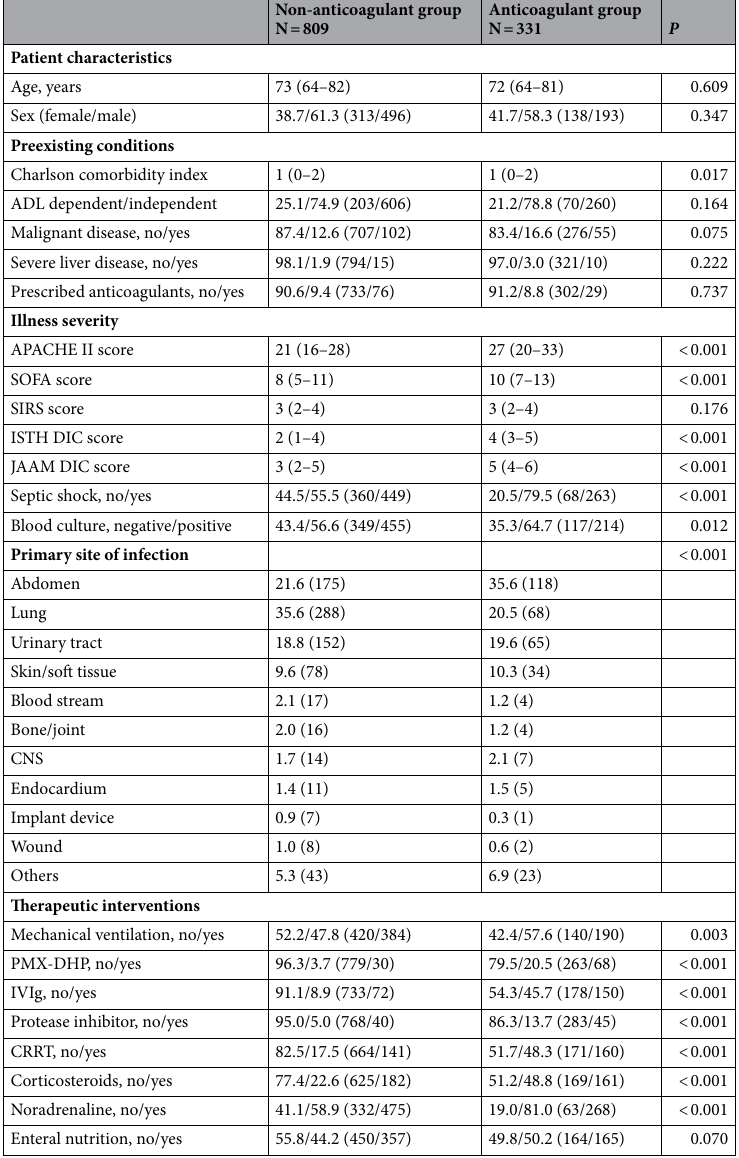
Table 1. Baseline clinical characteristics of the patients who did or did not receive anticoagulant therapy. Data are presented as proportions (counts) for categorical variables and medians (interquartile ranges) for continuous variables. Anticoagulant therapy was defined as the administration of antithrombin, recombinant human thrombomodulin, or their combination in the present study. ADL, activities of daily living; APACHE, Acute Physiology and Chronic Health Evaluation; CNS, central nervous system; CRRT, continuous renal replacement therapy; DIC, disseminated intravascular coagulation; IVIg, intravenous immunoglobulin; ISTH, International Society on Thrombosis and Haemostasis; JAAM, Japanese Association for Acute Medicine; PMX- DHP, polymyxin B direct hemoperfusion; SIRS, systemic inflammatory response syndrome; SOFA, Sequential Organ Failure